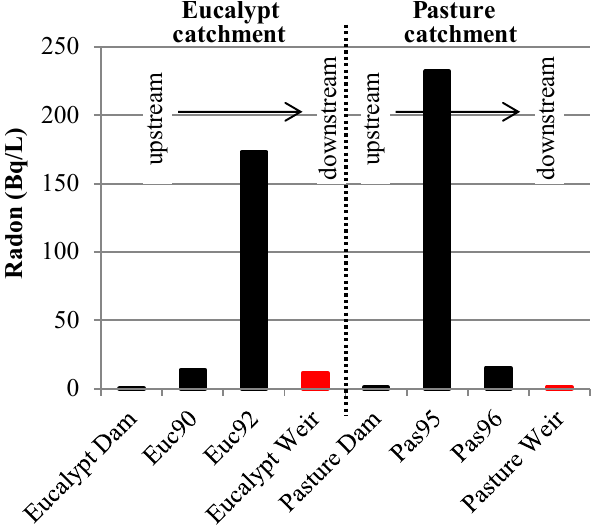
Figure 8. 222 Rn concentrations in the streams, measured at the weirs of both sites, and nearby bores. Surface water from further up the catchments is represented by water from dams located ups- lope in both catchments. The relatively high levels in the ground- water are a result of the decay of uranium present in the allanite and zircon of the granite.